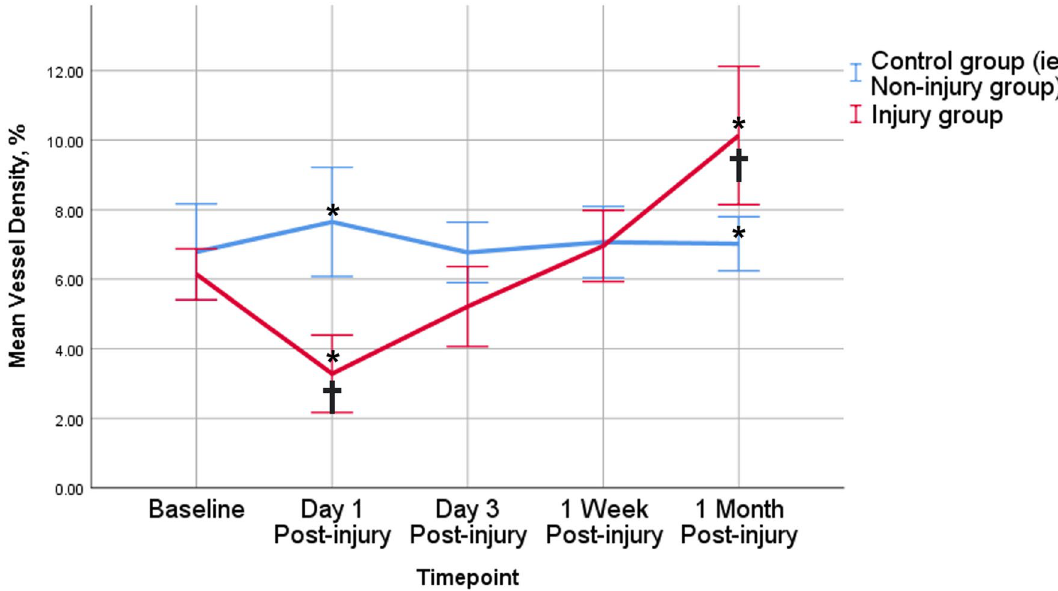
Figure 3. Comparison of changes in mean anterior segment-optical coherence tomography angiography vessel density (AS-OCTA) over time in both chemical injury and control quadrants. Error bar represents 95% confidence interval. *Statistically significant difference in mean vessel density between chemical injury and control groups at the same timepoint.